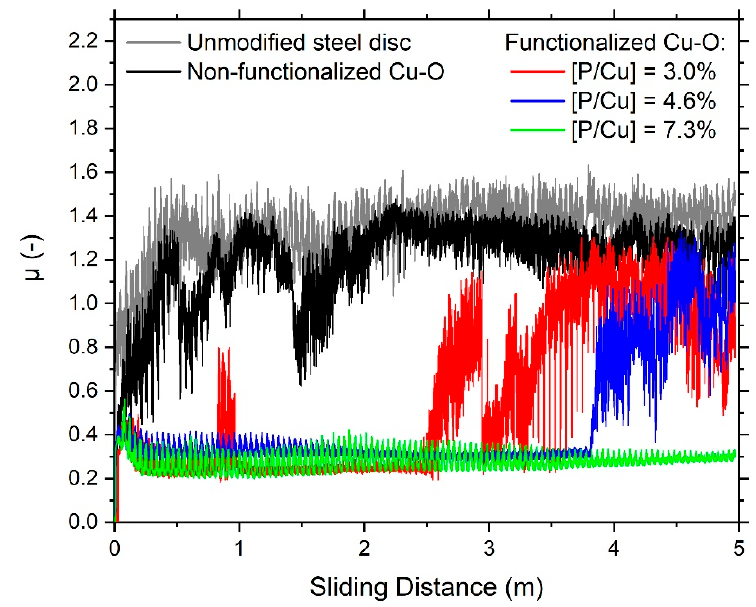
Figure 3. Friction coefficient µ measured for aluminum sliding over Cu–O coated steel surfaces without and with C18PA functionalization of different molecular coverages and over an unmodified steel disk. Coverages are indicated by P/Cu-ratios.